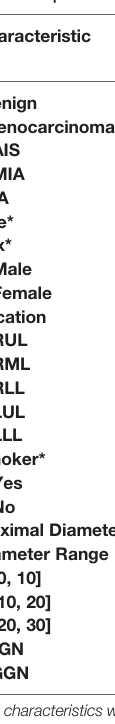
TABLE 1 | Characteristics of the GGNs in two